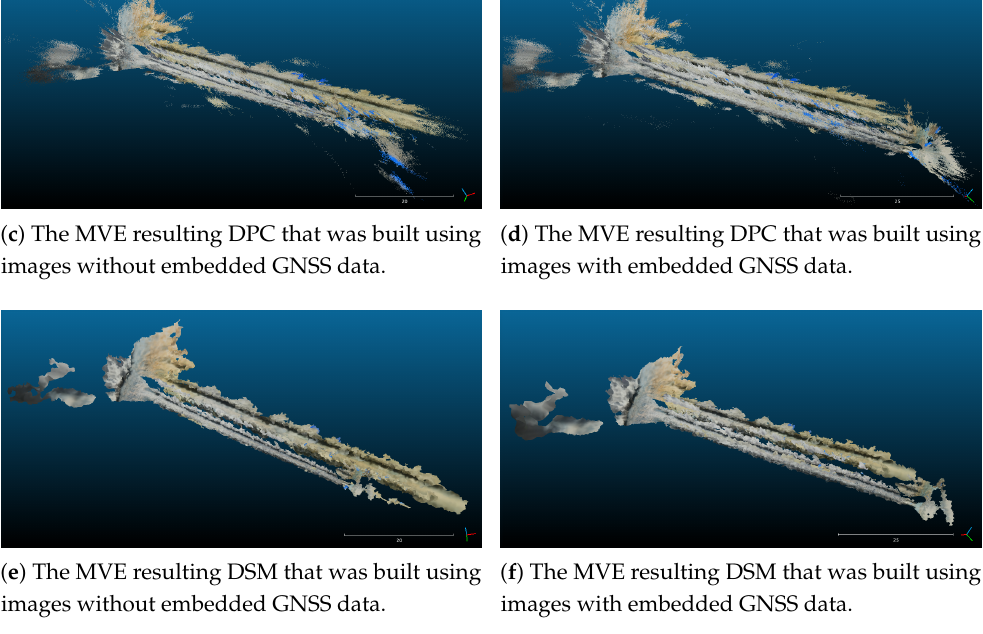
Figure 8. SPCs ( a , b ), DPCs ( c , d ) and DSMs ( e , f ) obtained from OpenMVG and MVE. The left and right columns refer to models which were constructed using images without and with Exif GNSS data, respectively. These images are screenshots taken from CloudCompare Viewer [23].